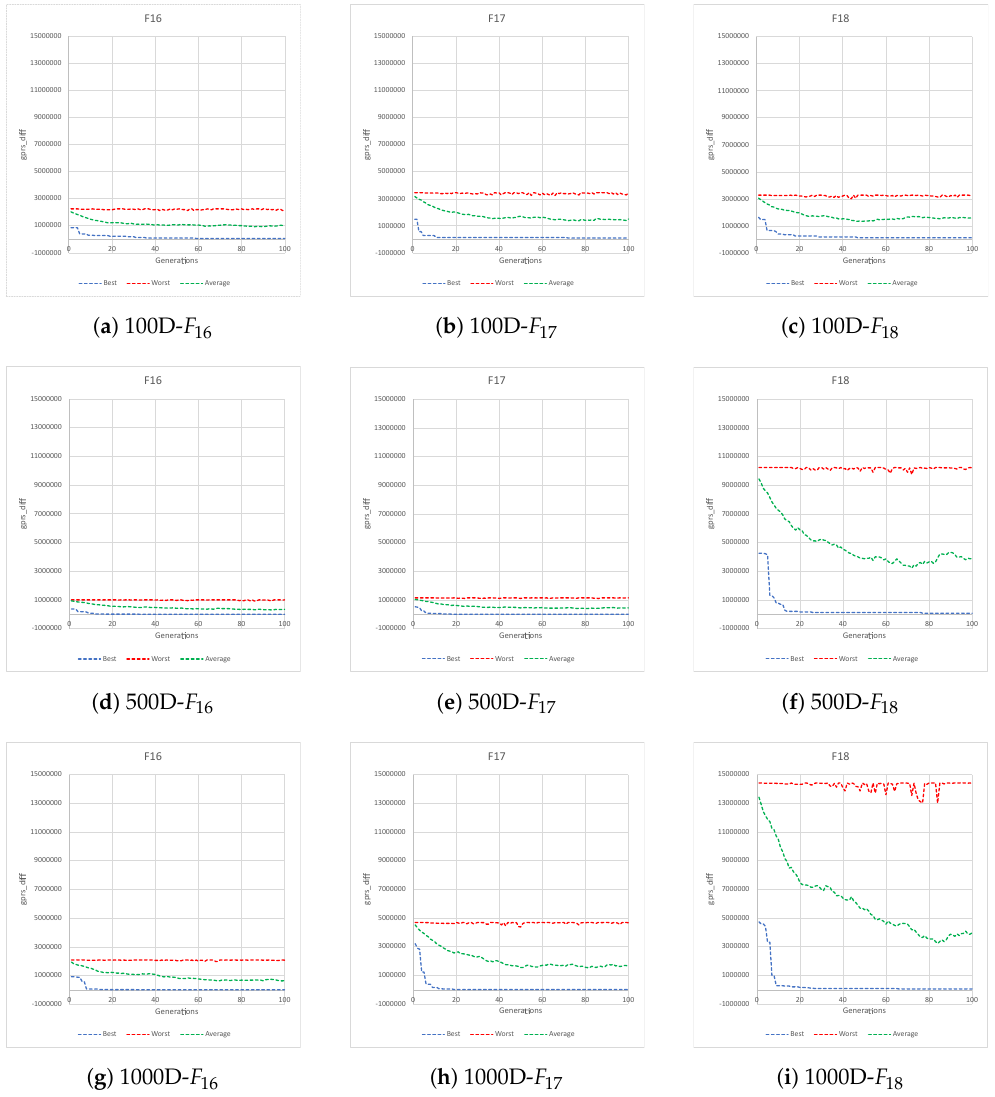
Figure 4. Convergence plots of 100 generations for functions F 16 , F 17 , and F 18 with 100, 500, and 1000